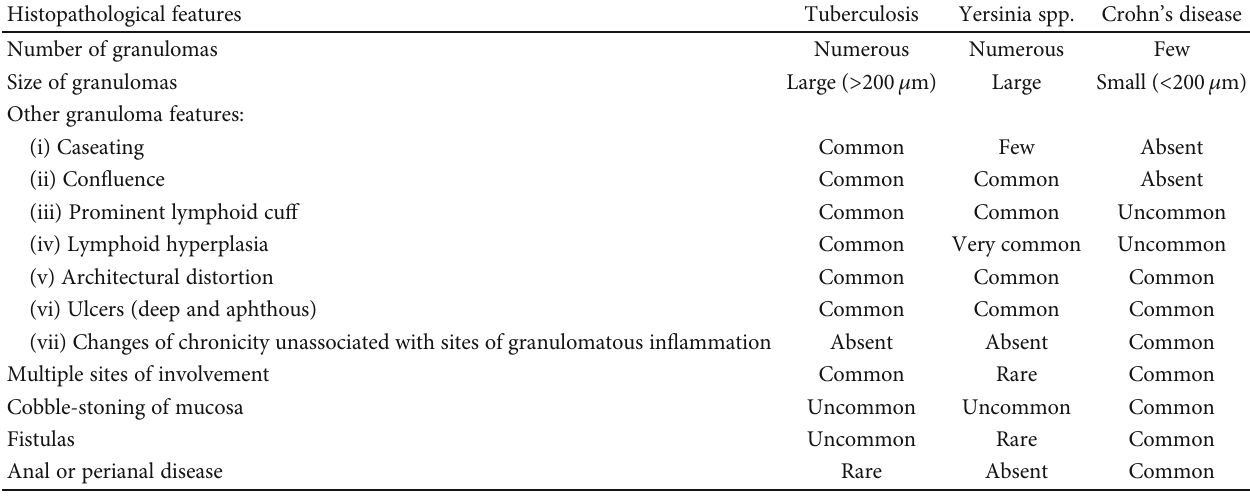
Table 4: Comparison of histological features between Mycobacterium tuberculosis , Yersinia , and Crohn ’ s disease [2, 75]. Histopathological